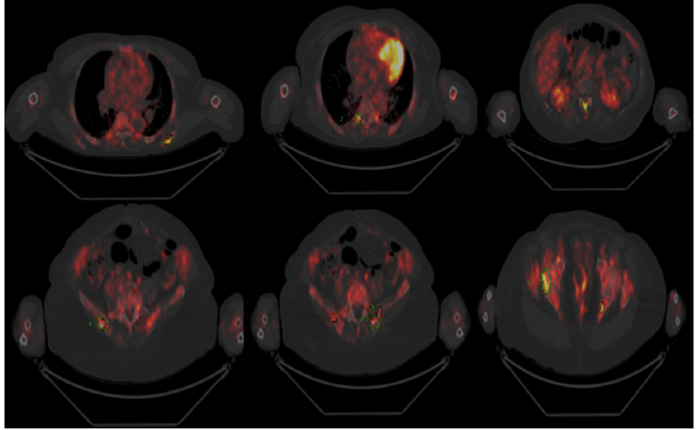
Figure 1. PET/CT scan: uptake in the right scapula, L1 vertebral level, and multifocal uptakes in the pelvis.